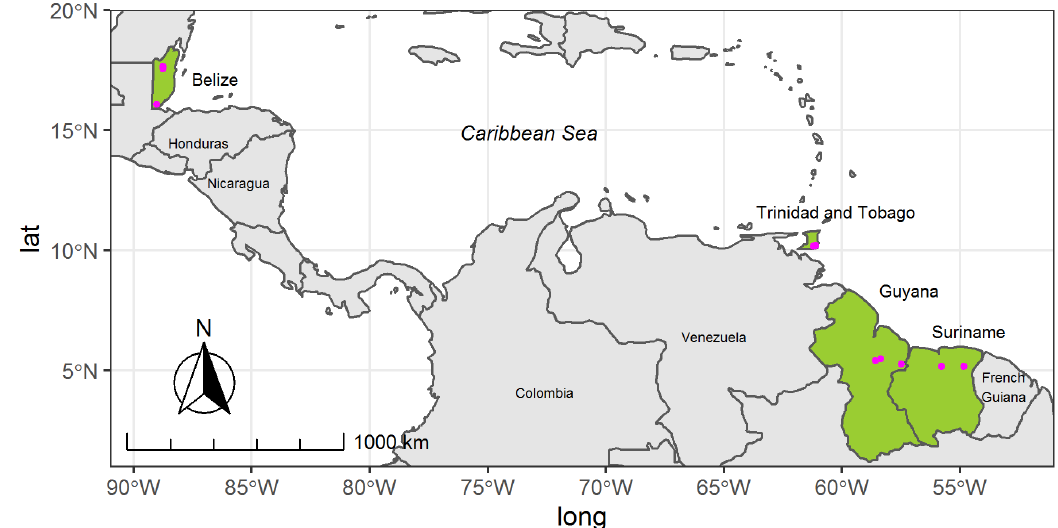
Figure 1. Project countries (green) and study sites (magenta).